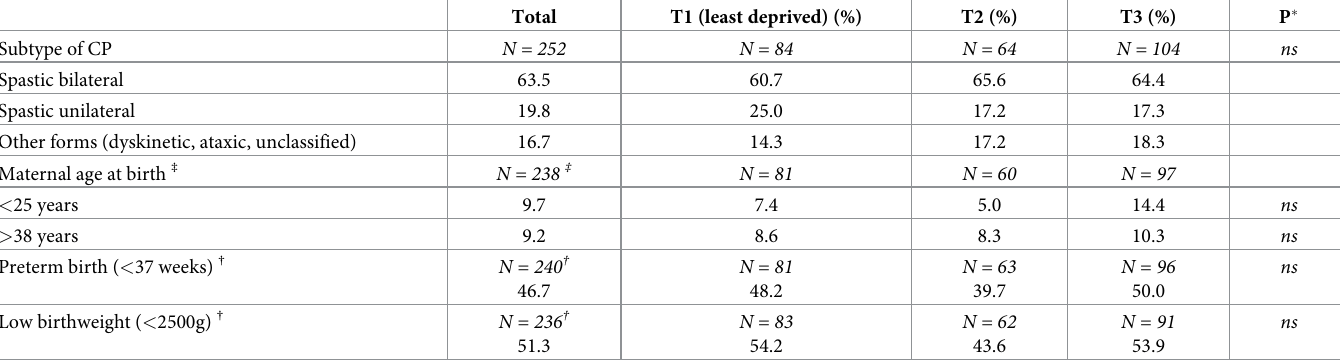
Table 3. Proportion of sub-types of cerebral palsy, maternal age at birth and perinatal characteristics of the children included (born 2000–2011) by census block groups defined by European Deprivation Index (EDI) distribution tertiles after weighting for the number of 8-year-old children residing in each block. The 1 st ter- tile (T1) corresponds to the least